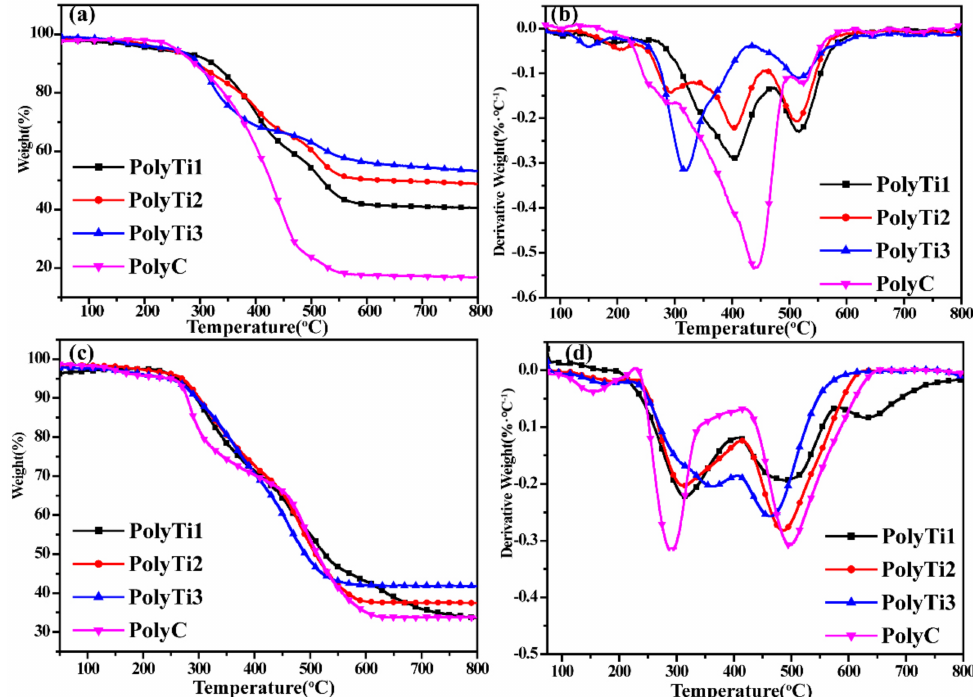
Figure 6. TGA and DTG curves of PolyTi and PolyC: ( a , b ) in N 2 ; ( c , d ) in